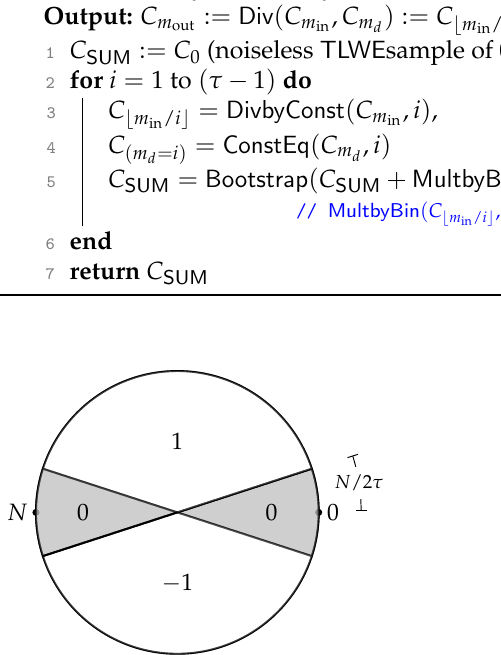
) : Homomorphic division. , C m in d